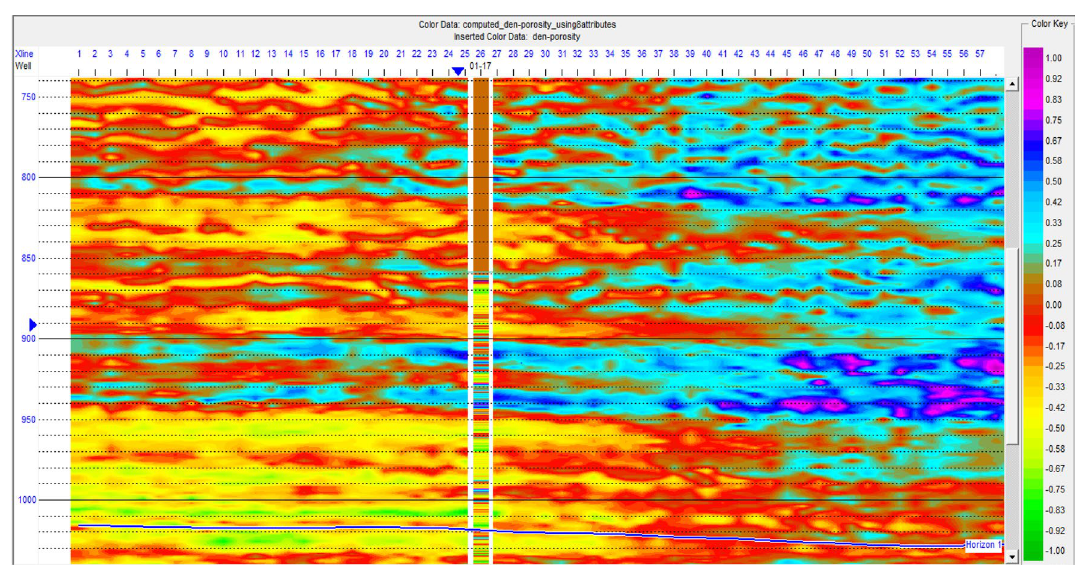
Fig. 11 Result in display of seismic acoustic impedance inversion based on a model generated for the location of well 8 (HRS)